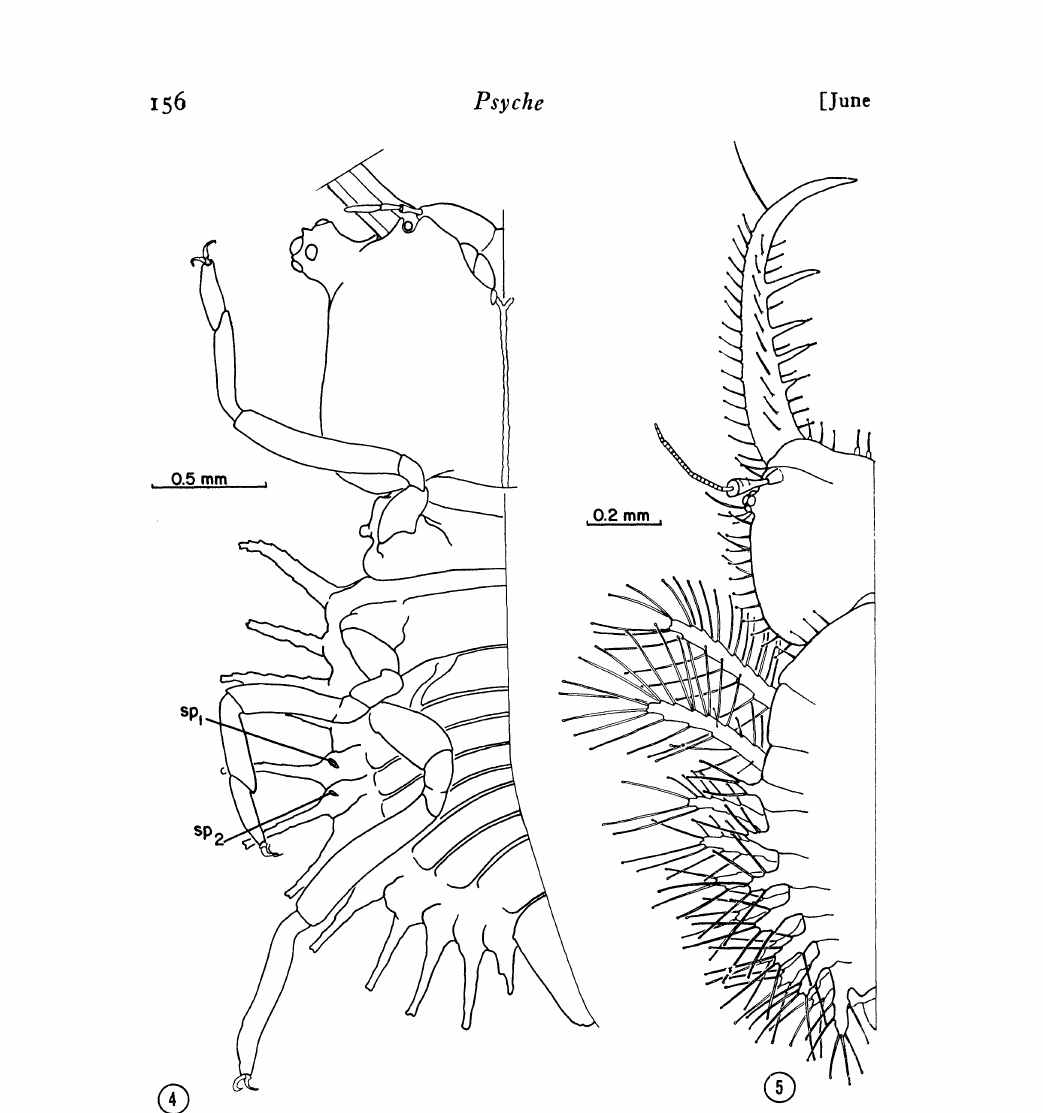
Figs. 4, 5. Larvae of Nymphidae and Ascalaphidae. Fig. 4. Neadelphus protae n. sp. Ventral view o.f holotype showing position of first two abdominal spiracles (spl, sp2) and leg segmentation, setae omitted. Fig. 5. Larvae of ?Pronymphes mengeanus (Hagen), dorsal view, show- ing details of lateral scoli; setae of dorsal head capsule and of body proper